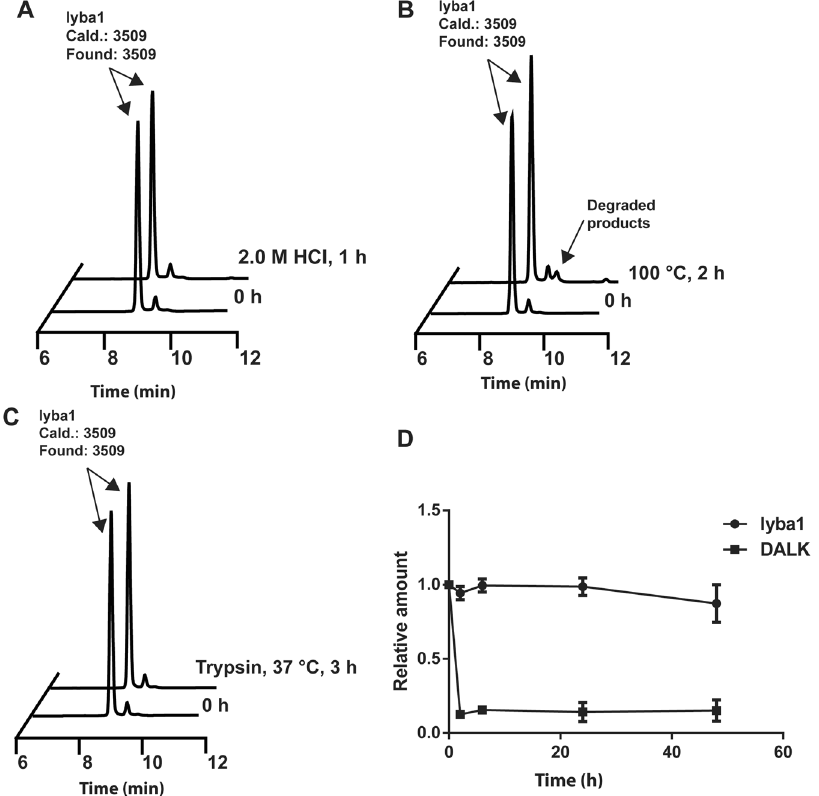
Figure 5. Stability assays of lybatide, lyba1. ( A ) Thermal stability of lyba1 incubated at 100 °C for 2 h. ( B ) Acidic condition stability of lyba1 incubated in 2.0 M HCl (pH 2.0) for 1 h. ( C ) Trypsin enzymatic stability of lyba1 incubated for 3 h in buffer as suggest by manufactures at 37 °C. ( D ) Stability of lyba1 incubated in human serum for 60 min at 37 °C, DALK was used as a control. The molecular weight of the peak was determined by